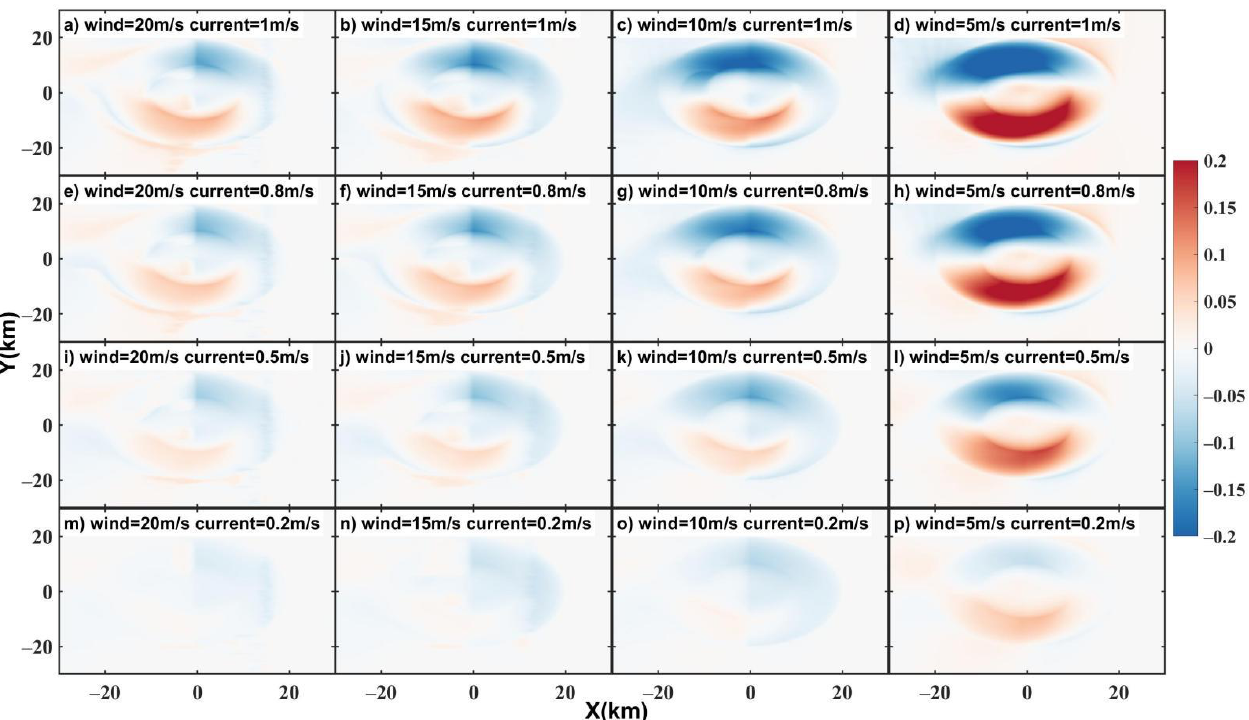
Figure 3. Relative H s differences modeled under the 16 cases listed in Table 2. The background color in the panels represents the relative differences.